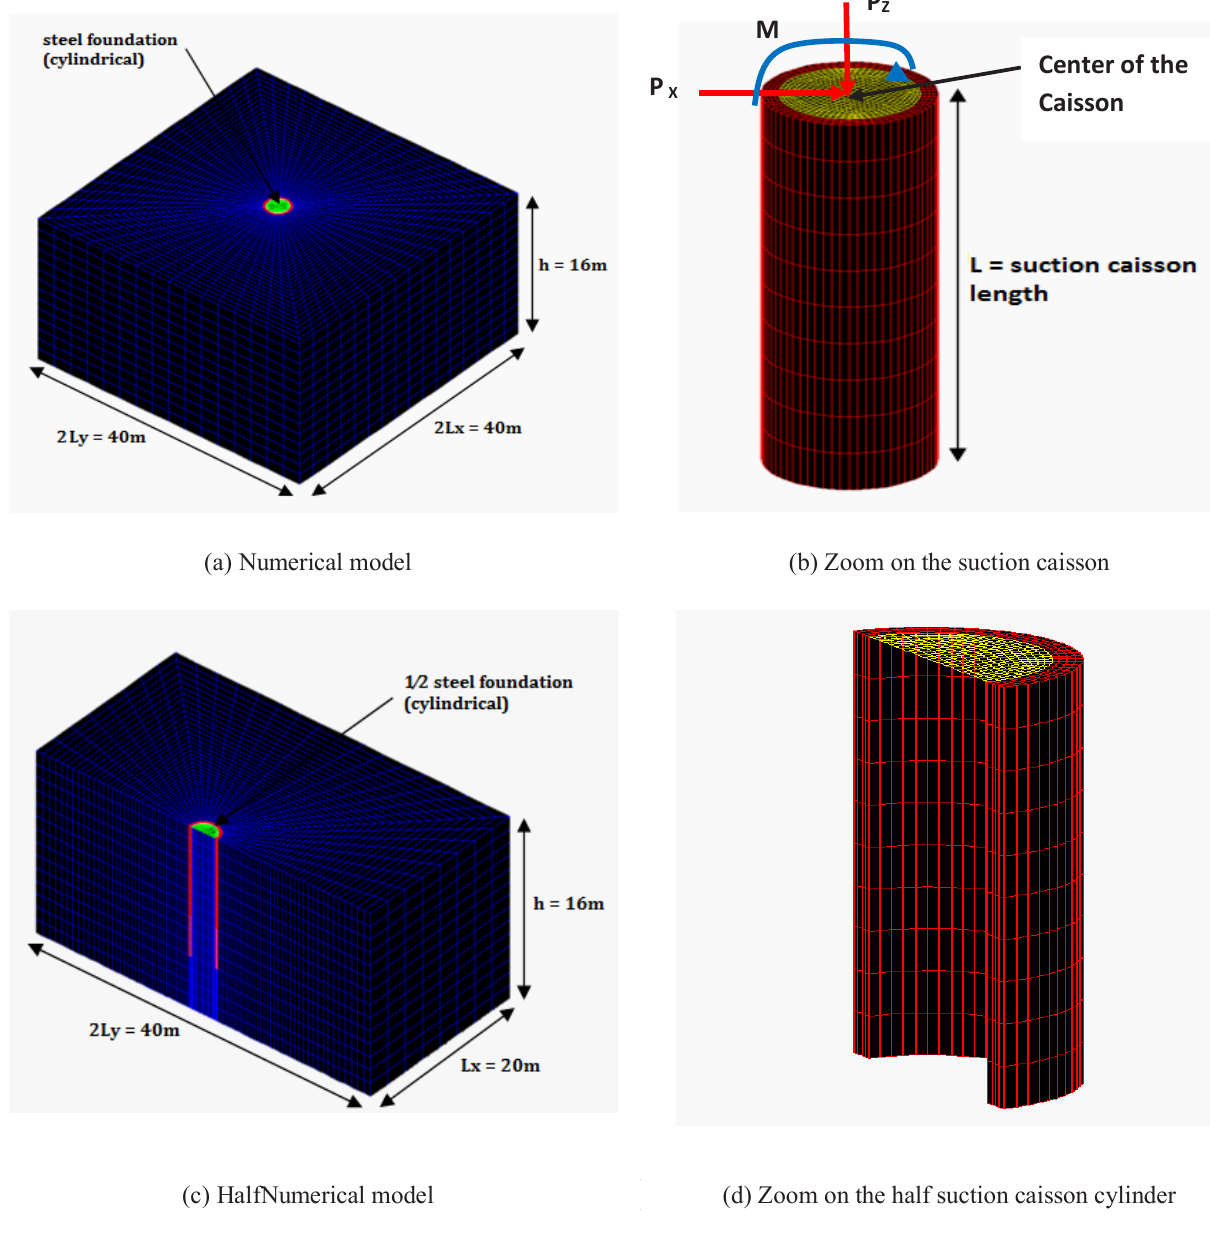
Figure 3: Used numerical